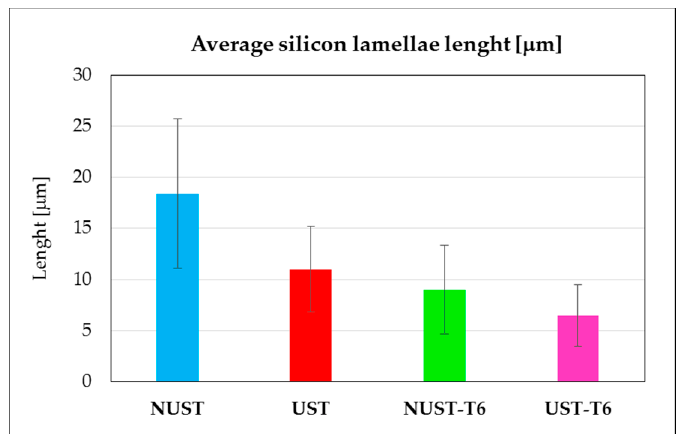
Figure 5. Average length of silicon lamellae.